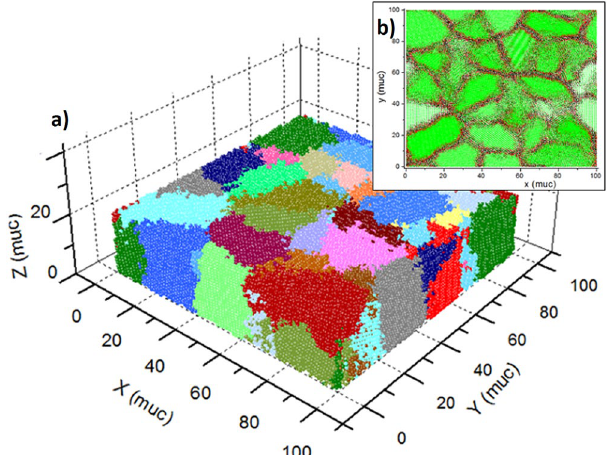
Figure 1. ( a ) Polycrystalline simulated sample with = L muc 100 = d muc 20 and = N ( ) 30 conditions along x - y plane can be identified looking at the colour distribution of the grains. ( b ) Surface view highlighting grain